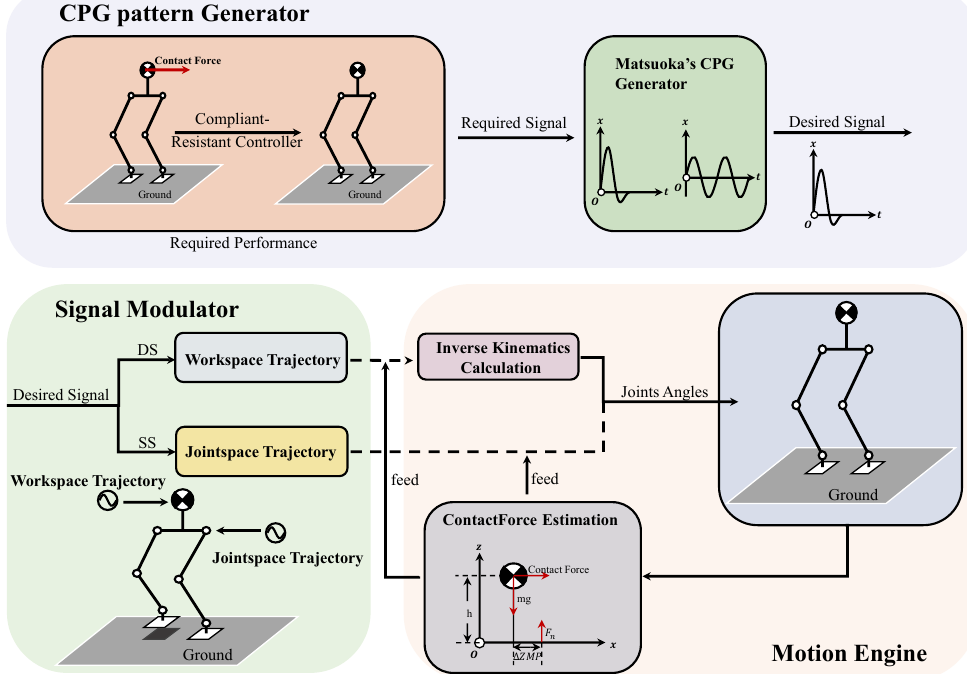
Figure 1. The architecture of the robot control system. In this diagram, the CPG pattern generator optimizes the output signal based on Matsuoka’s CPG model to the desired pulse pattern. The detailed generation and analysis of the signal are presented in Section 3. The signal modulator then modulates the desired signal to the workspace trajectory or the jointspace trajectory depending on the support types, double support or single support, and the deviation of the measured zmp and the projection of gravity is chosen as the feed term of the CPG model in section 4. h denotes the height of the CoM, F n denotes the ground support force measured by the force sensors, m denotes the mass of the robot, g is the gravitational constant, and ∆ ZMP is the deviation of the measured zmp and the projection of